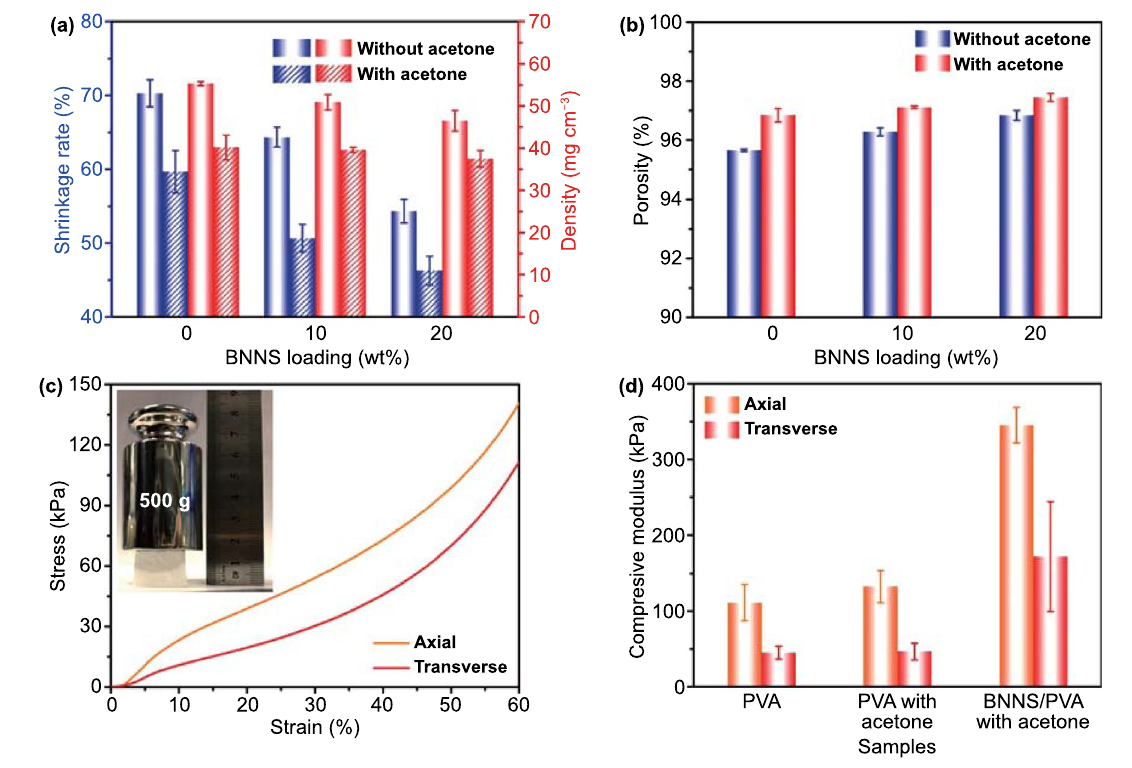
Fig. 2 Properties of BNNS/PVA composite aerogels. a Shrinkage rate and density and b porosity of BNNS/PVA composite aerogels made with or without 5 vol% acetone. c Stress–strain curves of BNNS/PVA composite aerogel in the axial and transverse directions (The inset is digital photograph of BNNS/PVA composite aerogel under a dead weight of 500 g). d Compressive modulus of aerogels in the axial and transverse